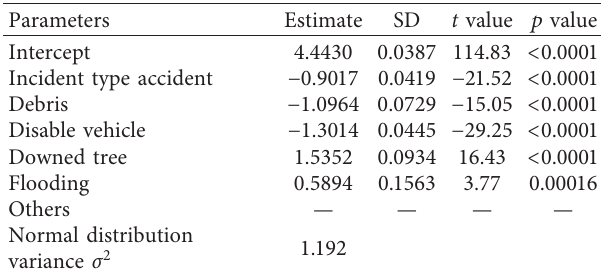
Table 4: Result statistics for the incident duration